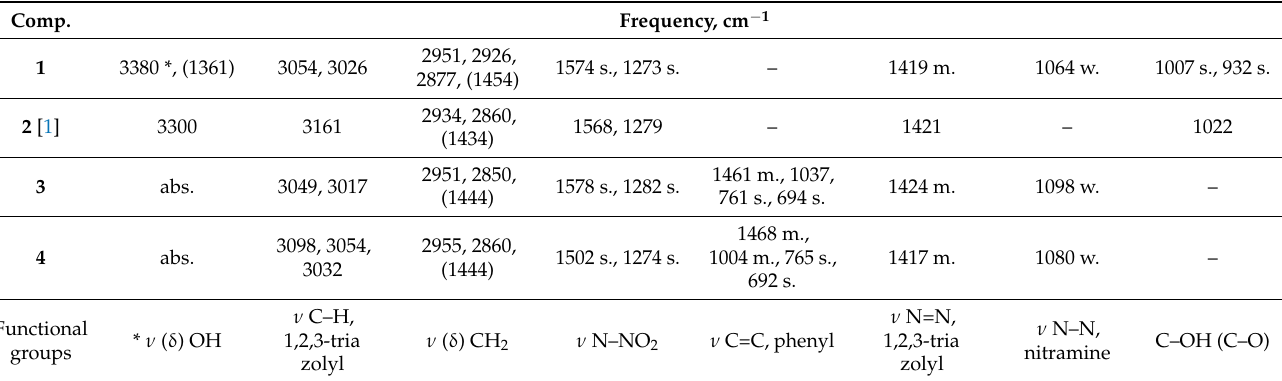
Table 7. Comparative basic infrared frequencies of compounds 1 – 4